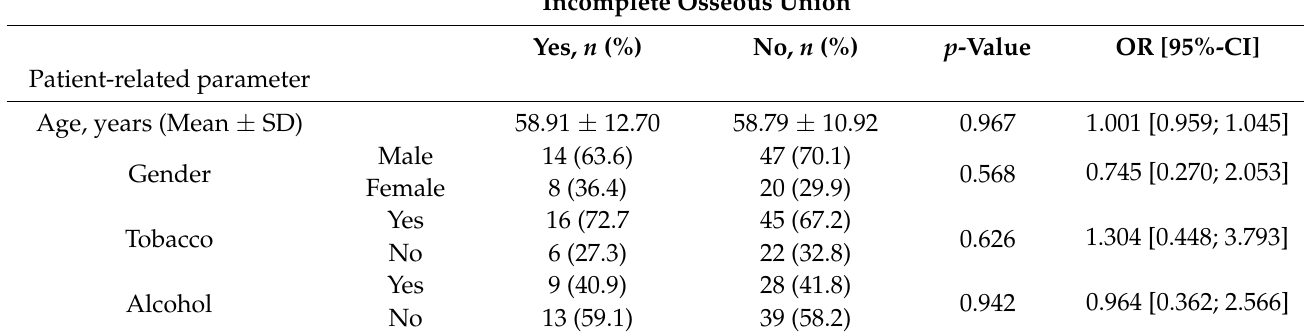
Table 4. Univariate analysis of patient, surgery, and complication-related parameters on the incom- plete osseous union. 95%-CI: 95%-confidence interval; OR: Odds ratio; PSI: patient-specific implant; SD: standard deviation; WHD: wound healing